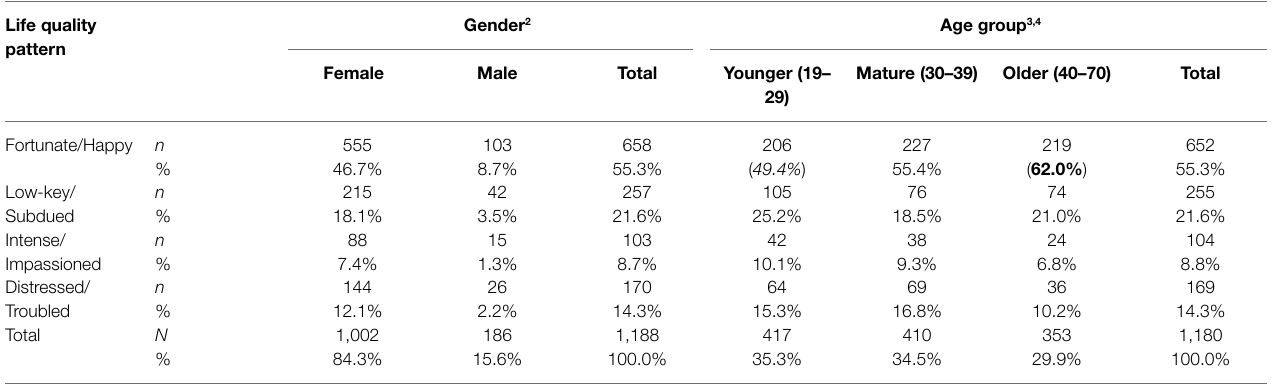
TABLE 4 | Trainees’ current life quality by gender and age. 1